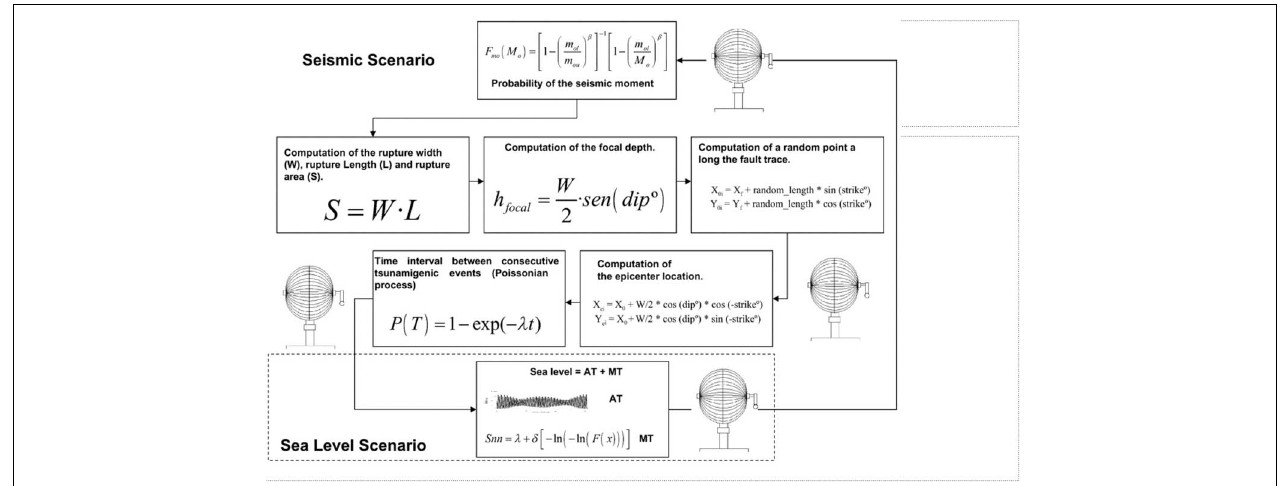
FIGURE 5 | Summary of the algorithm used to generate the synthetic catalog of tsunamis.